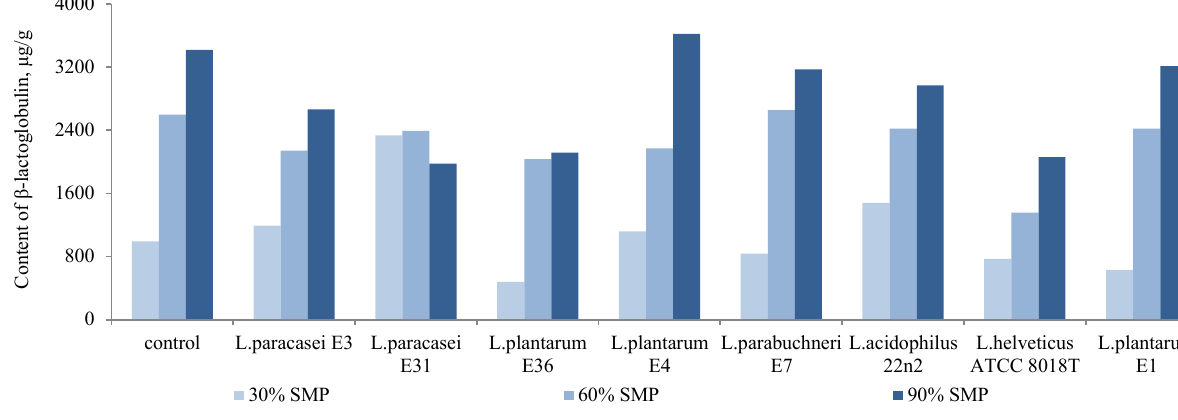
Figure 1 Content of β-lactoglobulin in the sourdoughs with various LAB strains after fermentation